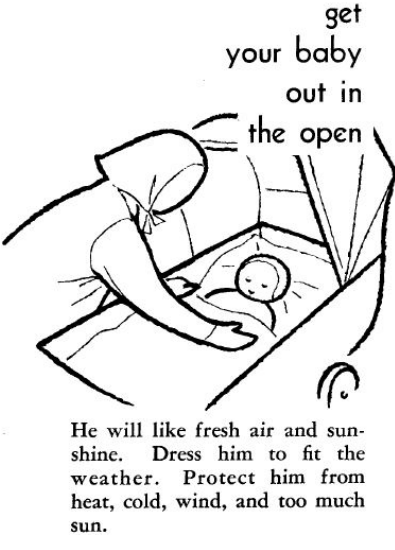
Figure 24. Fresh Air, but Caution about Too Much